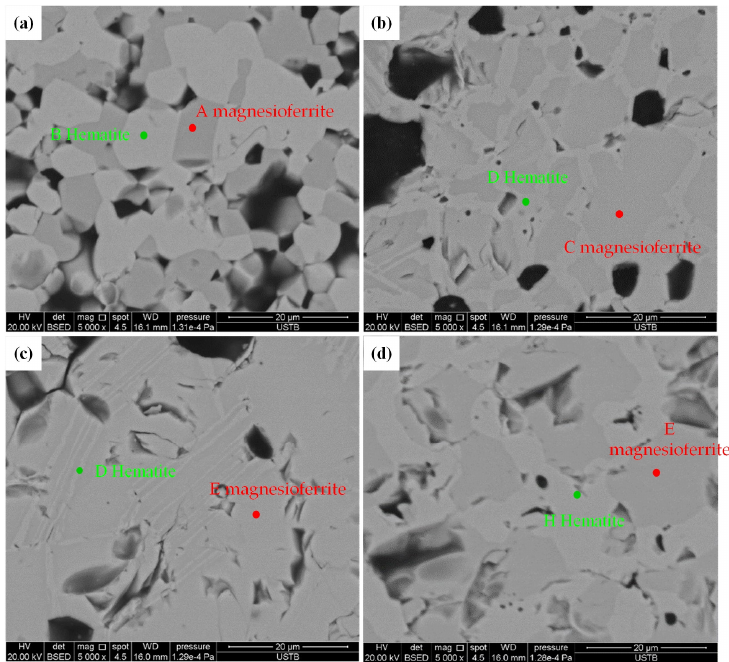
Figure 10. SEM image and EDS point of samples with 5.0 wt% MgO at different stages: ( a ) Stage 4, ( b ) Stage 7, ( c ) Stage 8, and ( d ) Stage 9 (grey—hematite; dark grey—magnesioferrite). Table 2. Element composition at every point from A to H from Stage 4 to Stage 9 (at%).